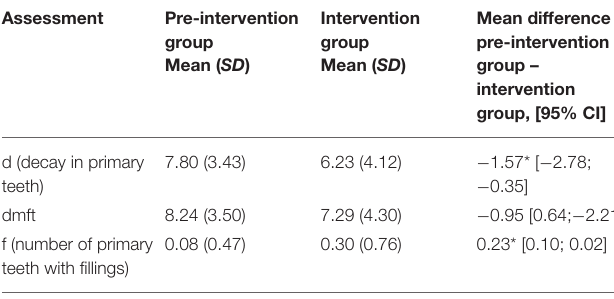
TABLE 2 | Decay levels in primary teeth pre-intervention and four years after the start of the program among 6–7-year old schoolchildren in Karakert and Lernagog villages.